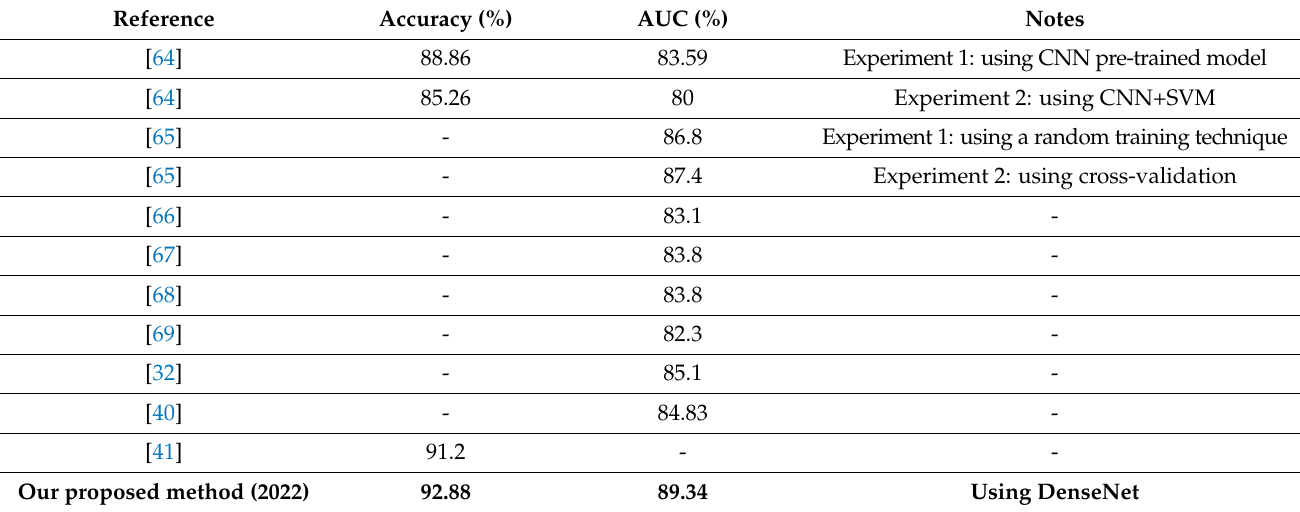
Table 5. Comparison results with findings from earlier